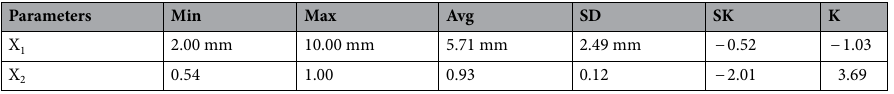
Table 2. The statistical values of the fitted GR2M model parameters. Remark: Min = Minimum; Max = Maximum; Avg = Average; SD = Standard deviation; SK = Skewness coefficient; and K = Kurtosis coefficient.